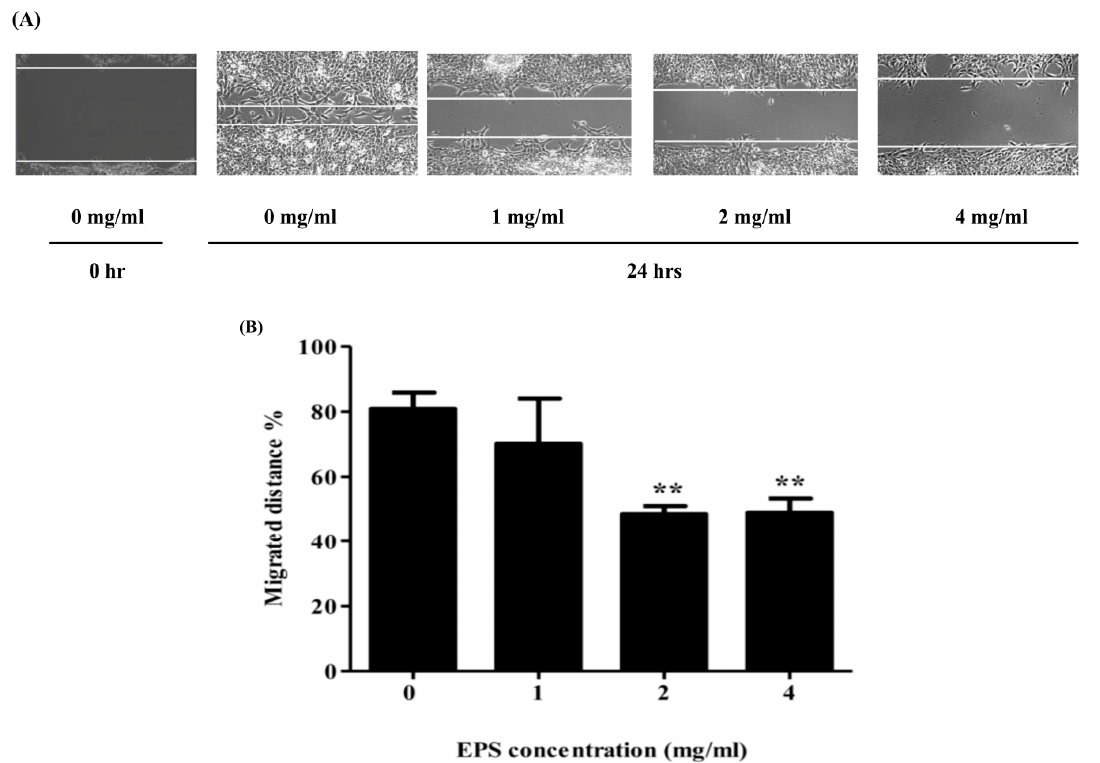
Figure 10. MOE6-EPS reduces the migration of 4T1 murine breast cancer cells. The 4T1 cells were cultured in 0, 1, 2 and 4 mg MOE6-EPS/mL. The wound healing was monitored for 24 h by real time microscopy and images were captured after 0 and 24 h. ( A ) Representative images of 3 independent experiments; ( B ) Quantification and statistical analysis of the migrated distance by 4T1 cells as a percentage of control. Values are means ± SD ( n = 3) where ** p < 0.01 indicate significant decreases from untreated cells.